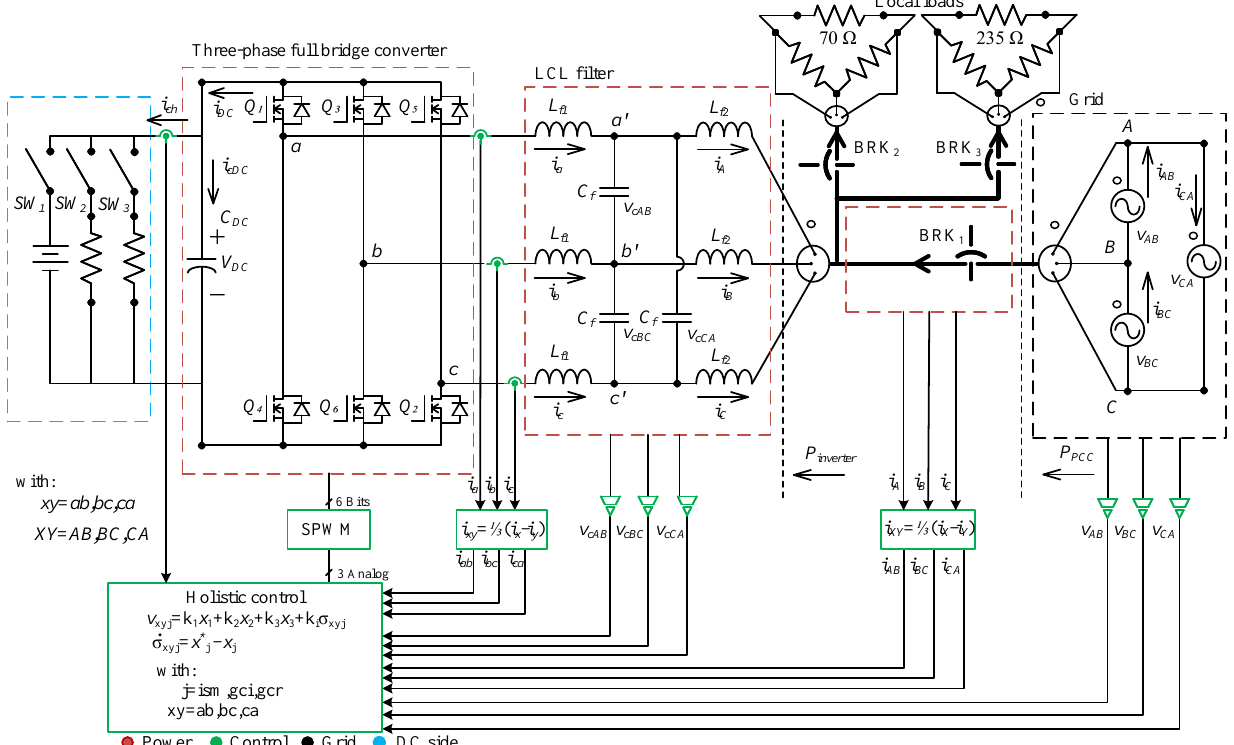
Figure 13. Whole BESS scheme used for